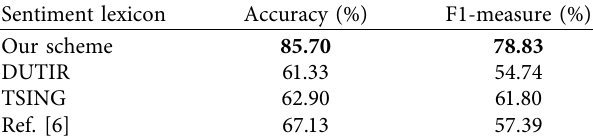
Table 5: The test results in a Chinese dataset on stock market. Sentiment